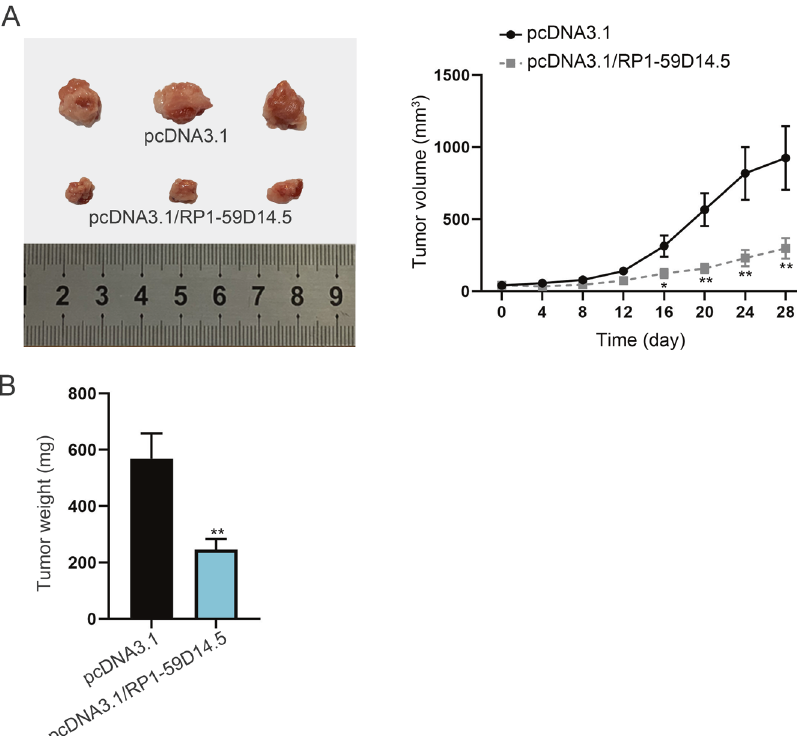
Fig. 7 RP1-59D14.5 inhibits tumor growth in PCa. A , B Images of xenografted tumors excised from the mice injected with pcDNA3.1- or pcDNA3.1/RP1-59D14.5-transfected PCa cells. Tumor volume and weight were measured. ** P <